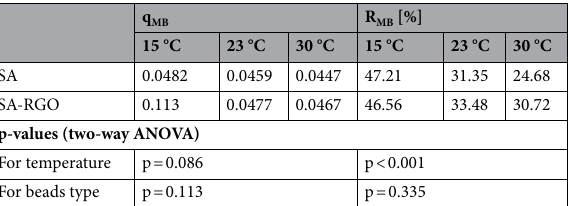
Table 3. The equilibrium absorption capacity coefficient (q MB ), methylene blue removal rate (R MB ), and p values calculated with two-way ANOVA; values p < 0.05 were considered as a statistically significant.